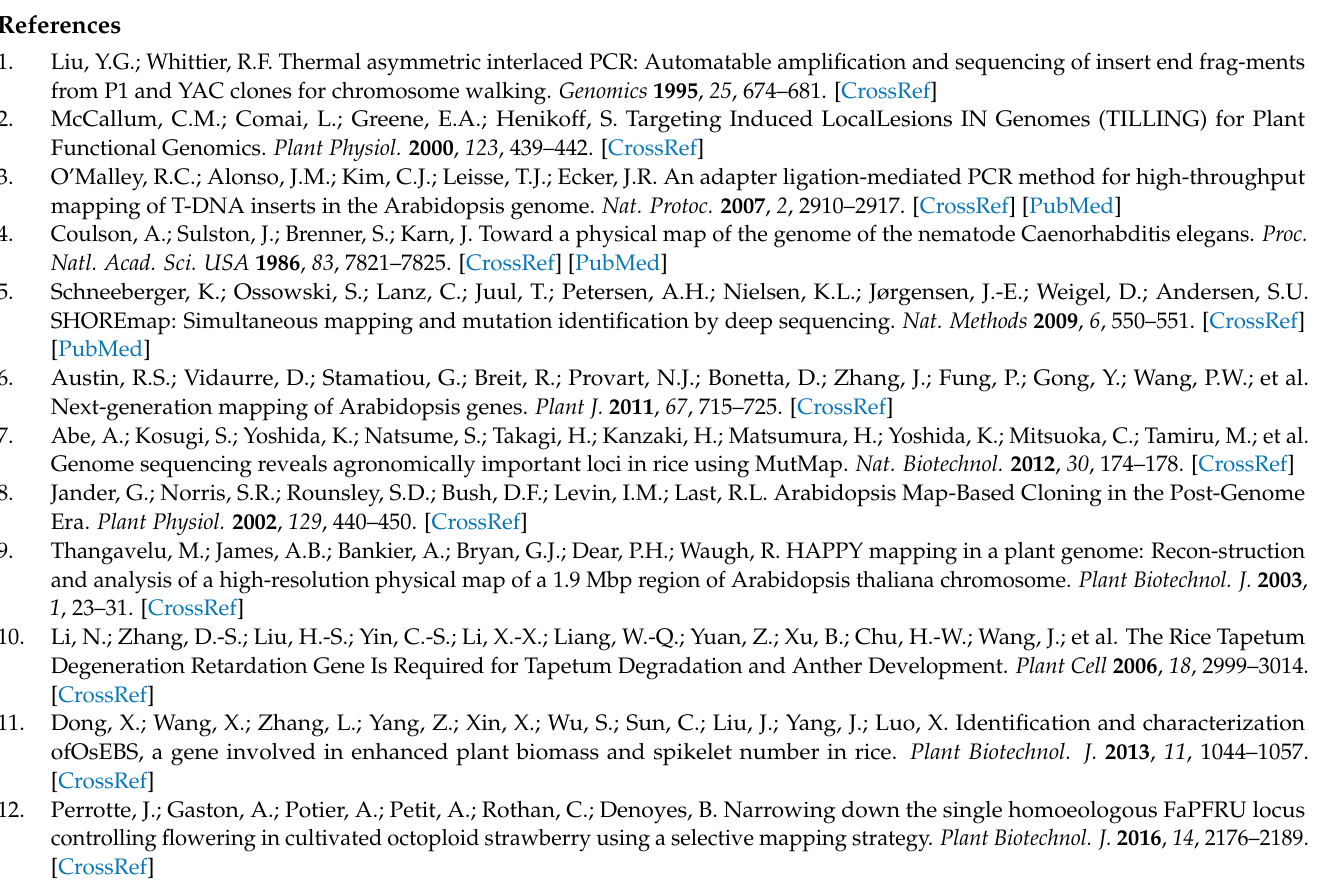
.3390/ijms22126224/s1, Figure S1. The simplified cloning scheme of the conventional map-based cloning method. Figure S2. The simplified cloning scheme for the homologous mutant. Figure S3. The PCR results of some SSLP markers in the BC 2 F 1 population of 275-3 . Figure S4. The ∆ marker- index plots of the mutant abs generated by the MutMap method. Figure S5. The PCR results of some SSR markers in the F 2 population of rice mutant abs . Figure S6. The PCR results of RM27618 and RM27715 in the F 2 population of rice mutant abs . Table S1. The preliminary analysis of the molecular markers in 275-3 ; Table S2. The analysis results of G value in ygs ; Table S3. The preliminary analysis of the molecular markers in ygs ; Table S4. The preliminary analysis of the molecular markers in abs ; Table S5. The sequences of